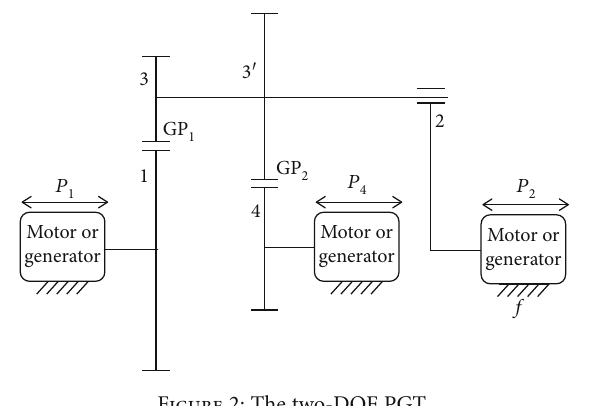
Figure 2: The two-DOF PGT.